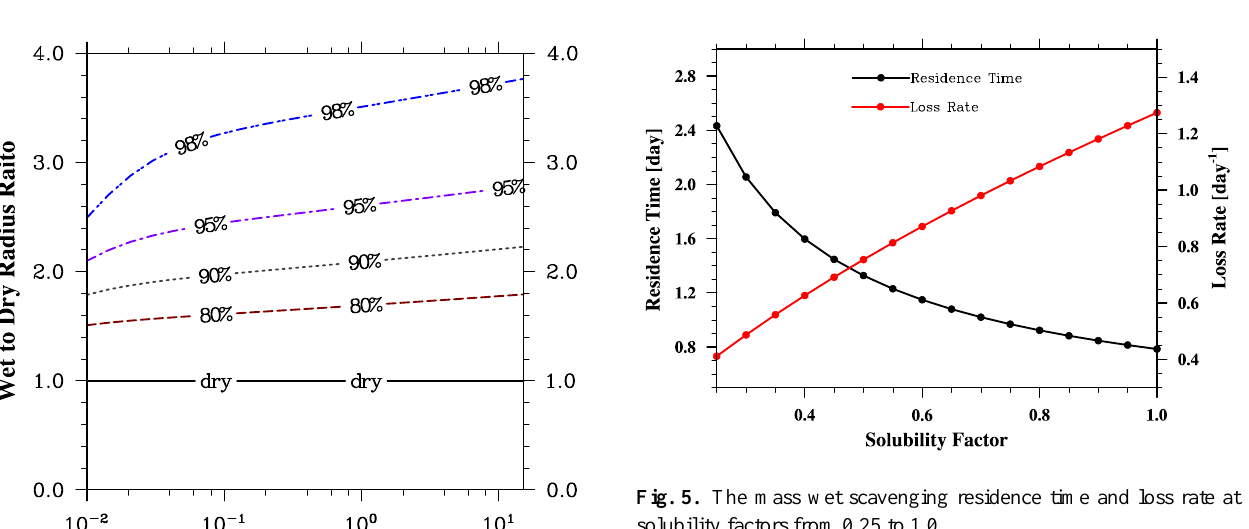
Here ρ is the density of dry sea-salt having a value of 2.17 g cm − 3 .